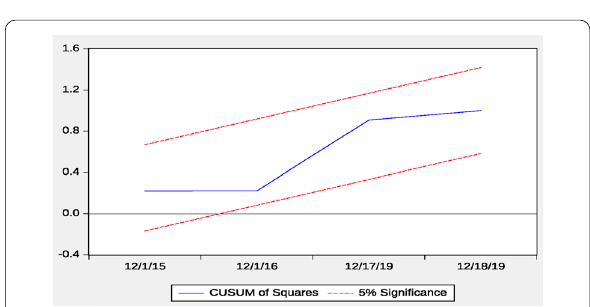
Fig. 7 Plot of cumulative sum of squares of recursive residuals. Source Generated by the author using Microfit